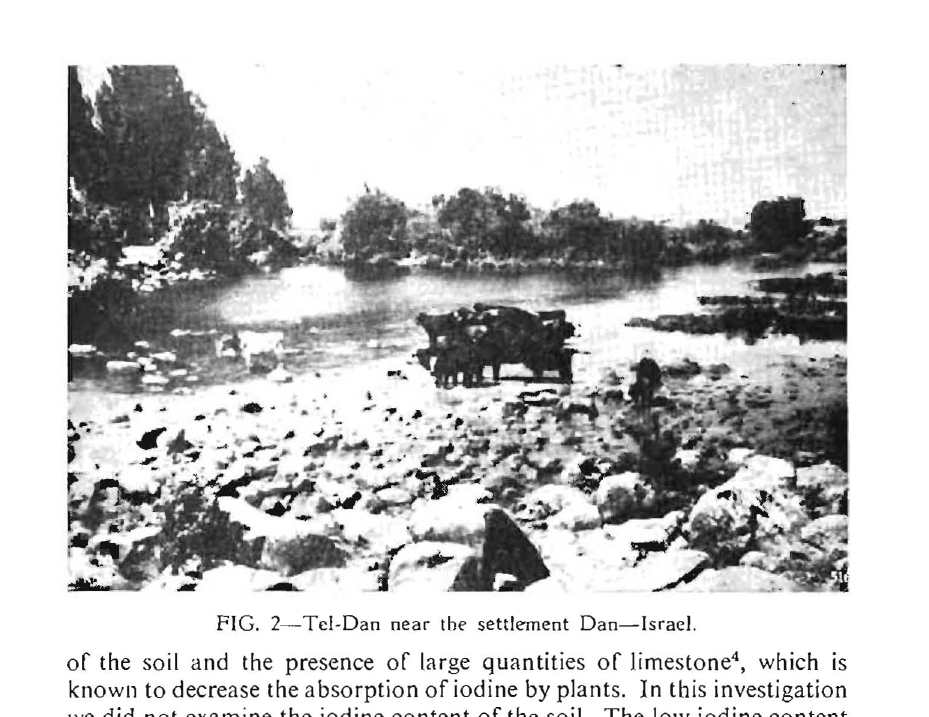
FIG. 2- Tel-Dan near tbe settle-ment Dan-Israel. or the soil and the presence or large quantities or limestone4, which is known to decrease the absorption of iodine by plants. In this investigation we did not examine the iodine content of the soil. The low iodine content (2-\0 micrograms/I) in milk of cows in the Upper Galilee and the much higher content (60-100 micrograms/ I) in the coastal plain, despite identical artificial pastures. seems to reflect the iodine content of the drinking water of both regions. The low intake of iodine from milk, therefore, may represent an additional factor in the goitre incidence of the Upper Galilee.